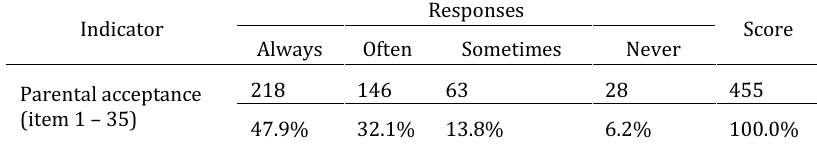
A summary of responses on parental acceptance